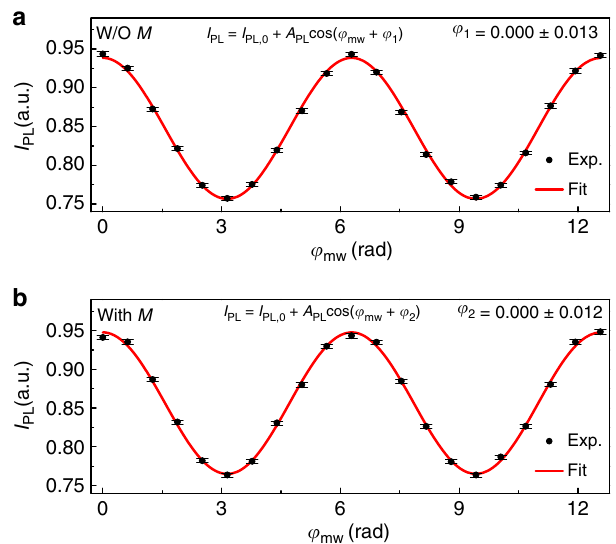
Fig. 3 Experimental results for detecting the electron – nucleon interaction. a The measured photoluminescence intensity I PL without M . b The measured photoluminescence intensity I PL with M . In both panels, the experimental data are represented by black circles with error bars, and the red solid lines represent the fi tting of the experimental data. Each experimental data is the average with six million experimental trails, which are divided into 1200 samples. Error bars of the experimental data represent s.e.m., which are calculated as the sample standard deviations divided by the square root of the sample size. The parameter values A PL = 0.091(1) and I PL,0 = 0.8476 (8) ( A PL = 0.091(1) and I PL,0 = 0.8563(8)) are obtained by fi tting the experimental data for the cases without M in panel a (with M in panel b ). The phases φ 1 and φ 2 are the accumulated phases of the states of S without and with M . The phase shift due to the electron – nucleon interaction between S and M is obtained by φ = φ 2 − φ 1 to be φ = 0.000 ± 0.018 Figure 2a shows schematically the distance d and correspond-